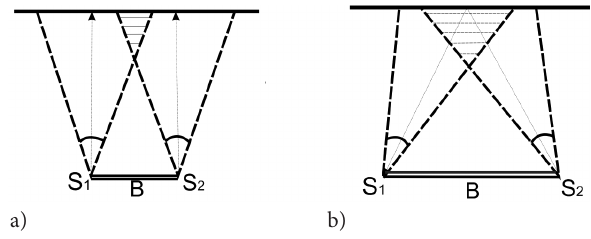
Figure 1. Normal: a – and convergent; b – survey methods To compare the accuracy of normal and convergent survey methods and modelling the images, it is recom- mended to use a program for generating simulated images (Figure 2).